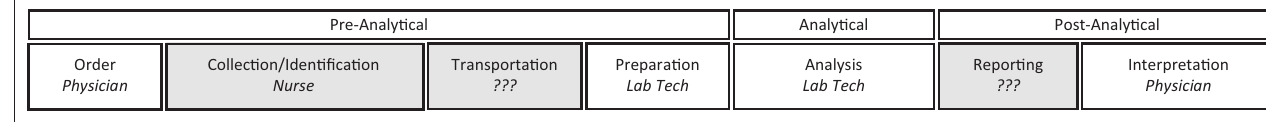
FIGURE1: Total testing process workflow at KCH.